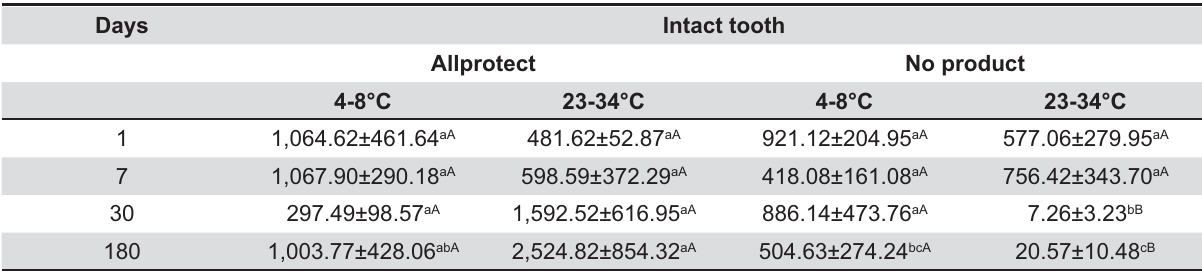
Table 1- (cid:2)(cid:3)(cid:4)(cid:5)(cid:6)(cid:2)(cid:5)(cid:6)(cid:7)(cid:2)(cid:8)(cid:9)(cid:5)(cid:6)(cid:7)(cid:5)(cid:10)(cid:7)(cid:2)(cid:7)(cid:4)(cid:11)(cid:12)(cid:5)(cid:9)(cid:12)(cid:13)(cid:6)(cid:2)(cid:13)(cid:14)(cid:2)(cid:9)(cid:15)(cid:4)(cid:2)(cid:16)(cid:17)(cid:5)(cid:6)(cid:9)(cid:12)(cid:18)(cid:19)(cid:5)(cid:9)(cid:12)(cid:13)(cid:6)(cid:2)(cid:13)(cid:14)(cid:2)(cid:20)(cid:4)(cid:6)(cid:13)(cid:21)(cid:12)(cid:19)(cid:2)(cid:22)(cid:23)(cid:24)(cid:2)(cid:25)(cid:26)(cid:2)(cid:10)(cid:4)(cid:5)(cid:27)(cid:28)(cid:9)(cid:12)(cid:21)(cid:4)(cid:2)(cid:29)(cid:30)(cid:31)(cid:2)(cid:12)(cid:6)(cid:2)(cid:9)(cid:15)(cid:4)(cid:2)(cid:20)(cid:10)(cid:13)(cid:17)!(cid:2)(cid:13)(cid:14)(cid:2)(cid:12)(cid:6)(cid:9)(cid:5)(cid:19)(cid:9)(cid:2)(cid:9)(cid:4)(cid:4)(cid:9)(cid:15)"(cid:2) samples 1-80 (ng/ μ L)